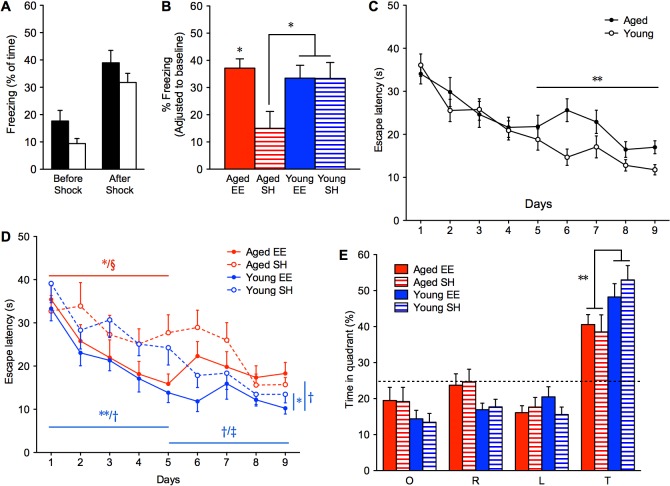
Assessment of aged and young mice after several weeks of undisturbed housing in EE or SH.(A) Fear conditioning in a novel context (FC2) and (B) memory test 24 hours later in the same context (n = 8, 6, 7, 7 for Aged EE (solid red), Aged SH (red stripes), Young EE (solid blue), Young SH (blue stripes), respectively; F
3,24 = 3.646). Escape latency to a hidden platform in an alternate Morris water maze and room (MWM2), different than that of MWM1, (C) by age and (D) separated by age and housing conditions (n = 11, 11, 11, 10 for Aged EE (red line), Aged SH (red dashes), Young EE (blue line), Young SH (blue dashes), respectively; days 1–5, F
3,39 = 5.524, p < 0.01; days 6–9, F
3,39 = 4.307, p < 0.05; days 1–9, F
3,39 = 4.652, p < 0.01; *p values shown with respect to aged (red) and young (blue); §
p < 0.05 (Aged EE to Young SH); †
p < 0.01 (Young EE to Aged SH); ‡
p < 0.05 (Young EE to Aged EE). Probe trial on day 10 with the hidden platform removed, (E) separated by age and housing conditions (O, opposite; R, right; L, left; T, target). *p < 0.05, **p < 0.01, ***p < 0.001. Shown as mean ± s.e.m.